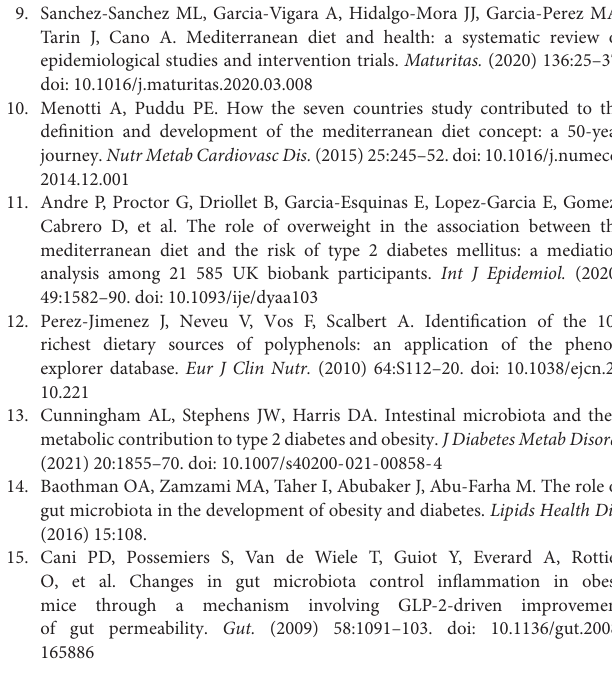
Figure S2 | Rarefaction curves of amplicon sequence variants (ASVs), showing depth of 16SrRNA gene sequencing of saliva samples. Figure S3 | Salivatype-1 when present in non-T2DM, obese and non-obese subjects had a similar decreased